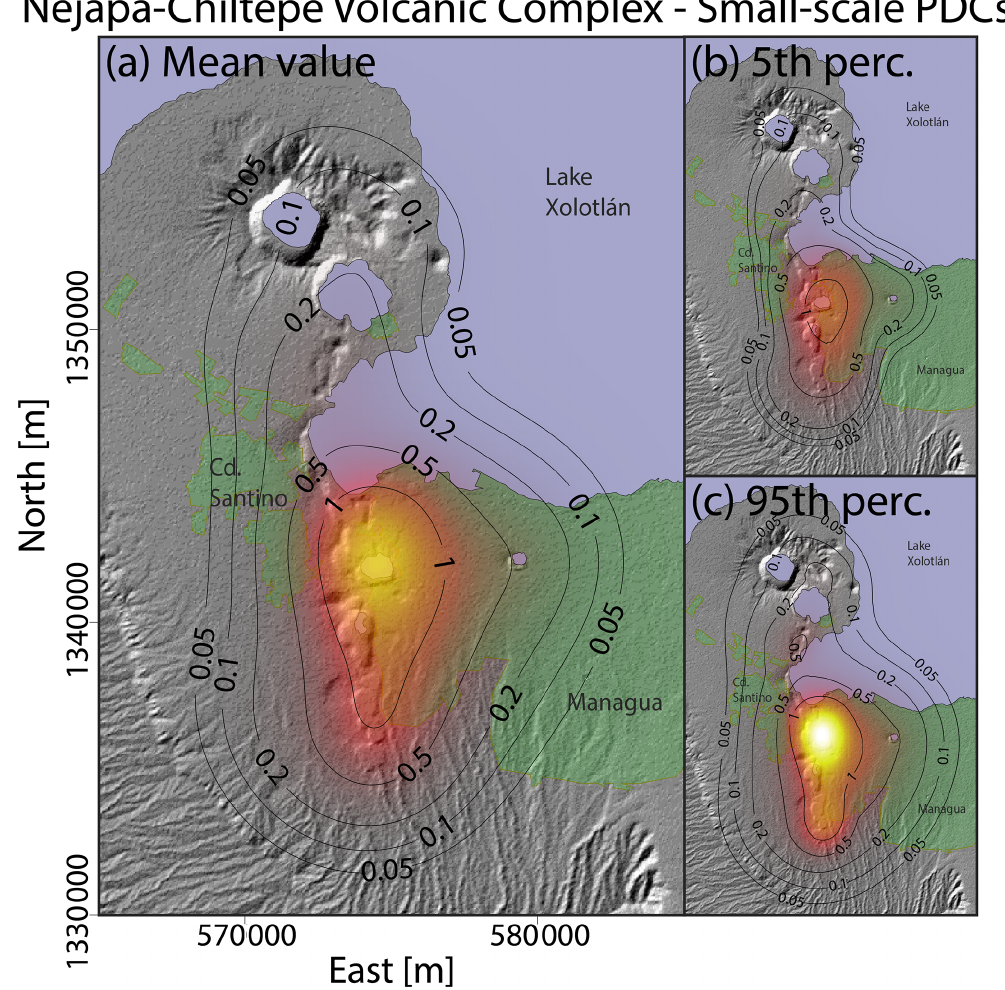
Figure 7. Density distribution of the probability of vent opening at the Nejapa-Chiltepe volcanic complex associated with the occurrence of volcanic activity able to produce small-scale pyroclastic density currents. (a) Mean value. (b) 5th percentile. (c) 95th percentile. Results are expressed in percentage per km 2